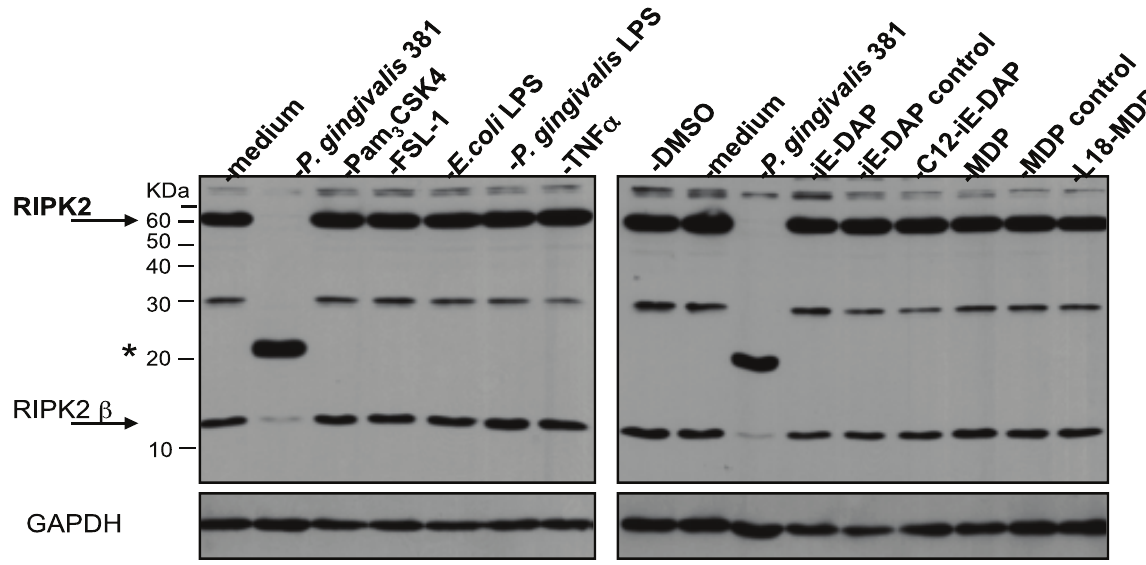
Figure 3. RIPK2 levels are stable in HAEC stimulated with TLR or NLR agonists. HAEC were treated with medium, P. gingivalis 381 (MOI 100), 10 m g/ml Pam 3 CSK4, 10 m g/ml FSL-1, 10 m g/ml P. gingivalis 381 LPS, 1.0 m g/ml E. coli 0111:B4 LPS, 100 ng/ml recombinant human TNF, 100 m g/ ml iE-DAP, 100 m g/ml iE-DAP control, 1000 ng/ml C12-iE-DAP, 0.01% DMSO (C12-iE-DAP vehicle control), 100 m g/ml MDP, 100 m g/ml MDP control, or 1000 ng/ml L18-MDP for 2 h. Whole cell lysates were analyzed for the detection of RIPK2 and GAPDH. Full-length RIPK2 and RIPK2 b are indicated with arrows. A prominent P. gingivalis -induced LMW band is indicated with an asterisk. MW ladder is indicated on the left in kDa.